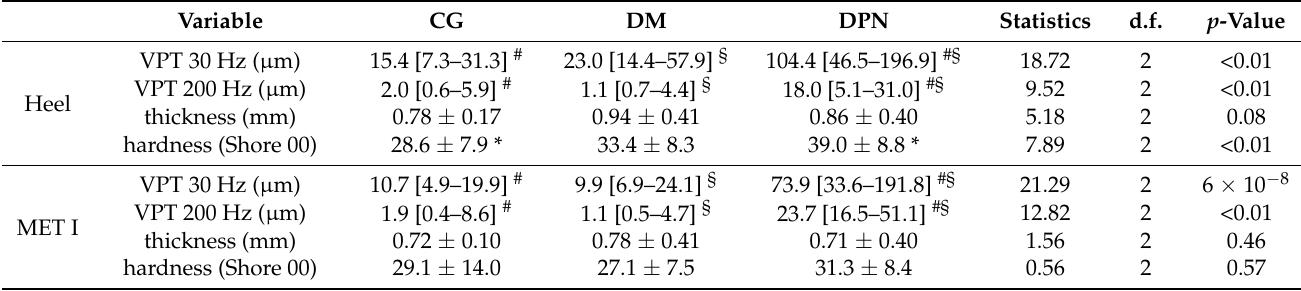
Table 1. Vibration perception thresholds and mechanical skin properties in healthy subjects and individuals with diabetes.